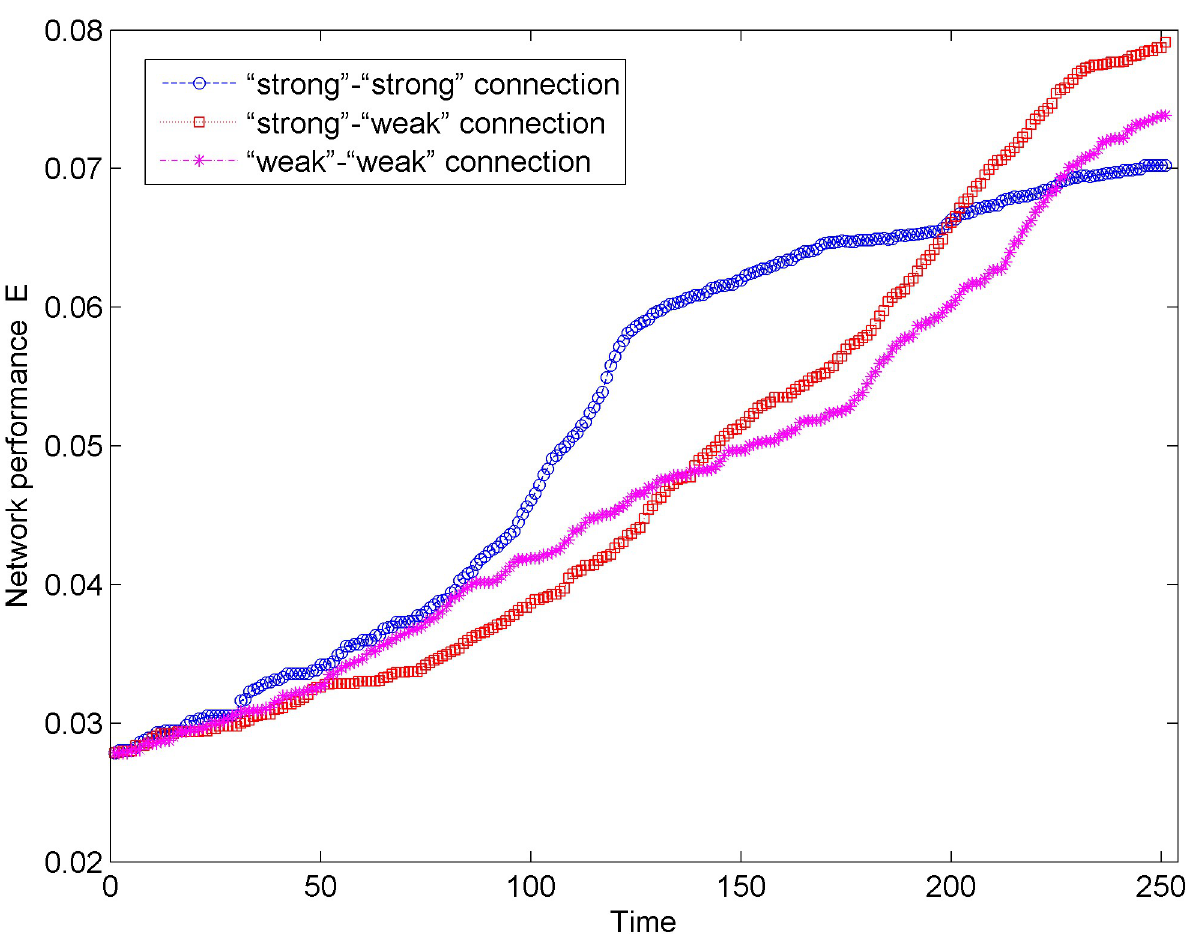
Fig 8. Changes of the maximum connected subgraph size in the weighted